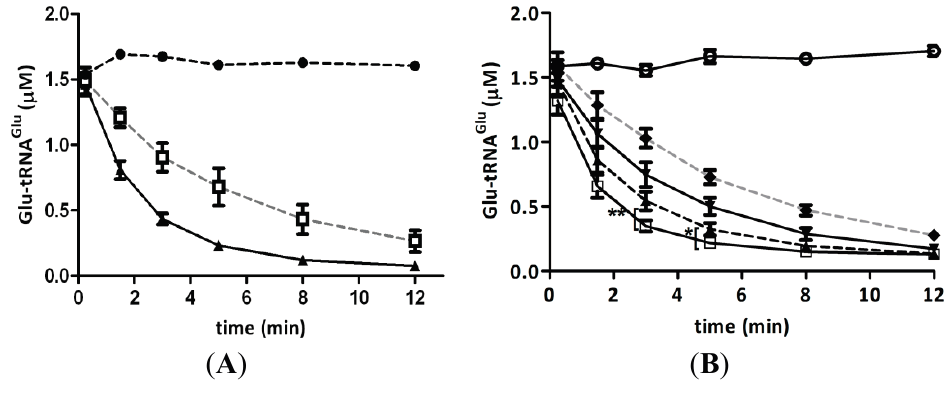
Figure 3. Stimulation of GluTR by glutamate semialdehyde 1-2 aminomutase (GSAM). ( A ) The effect of GSAM on GluTR activity was analyzed by determining the deacylation of Glu-tRNA 2Glu catalyzed by GluTR (1 µM heme/protein ratio of 1/12) alone ( □ ) or in the presence of GSAM ( ▲ ). Black circles ( ● ) correspond to deacylation of Glu-tRNA 2Glu without enzyme; ( B ) The effect of H 2 O 2 on GSAM stimulation of GluTR activity was evaluated by the deacylation of Glu-tRNA 2Glu catalyzed by GluTR (1 µM, heme/protein ratio of 1/12) in the presence of GSAM when GluTR ( ▼ ), GSAM ( ▲ ) or both enzymes ( ♦ ) were treated with 300 μ M H 2 O 2 . Control ( □ ) represents enzyme not treated with H 2 O 2 . Open circles ( ○ ) correspond to deacylation of Glu-tRNA 2Glu without enzymes. Asterisks represent statistically significant differences ( ** p = 0.008; * p =